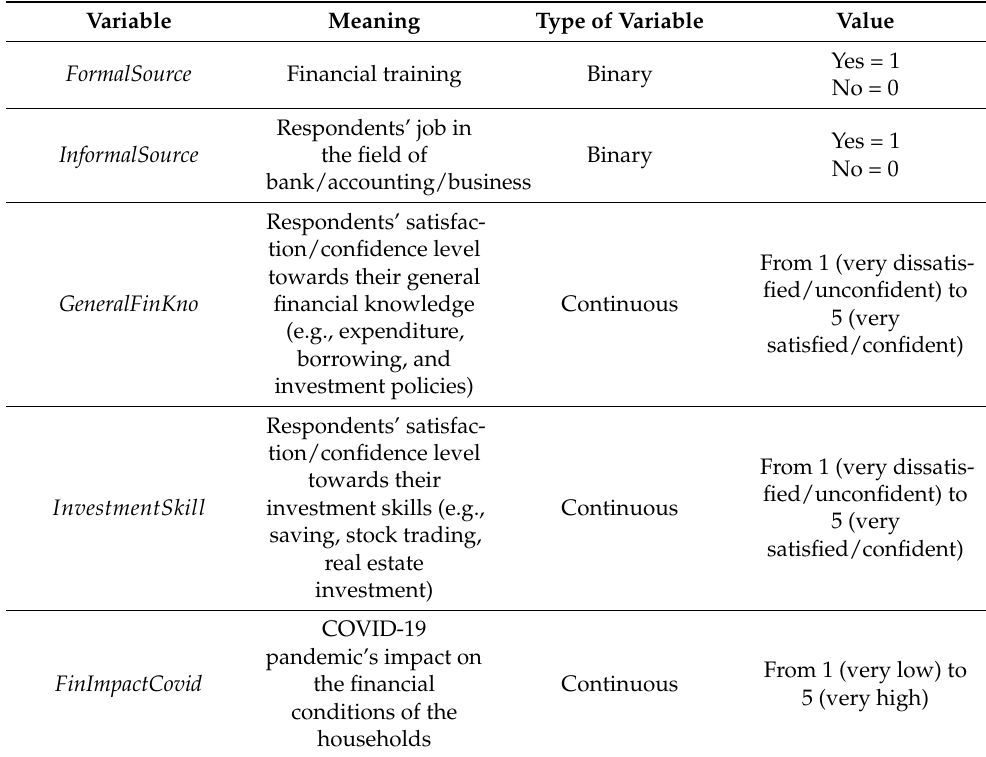
Table 1. Variable